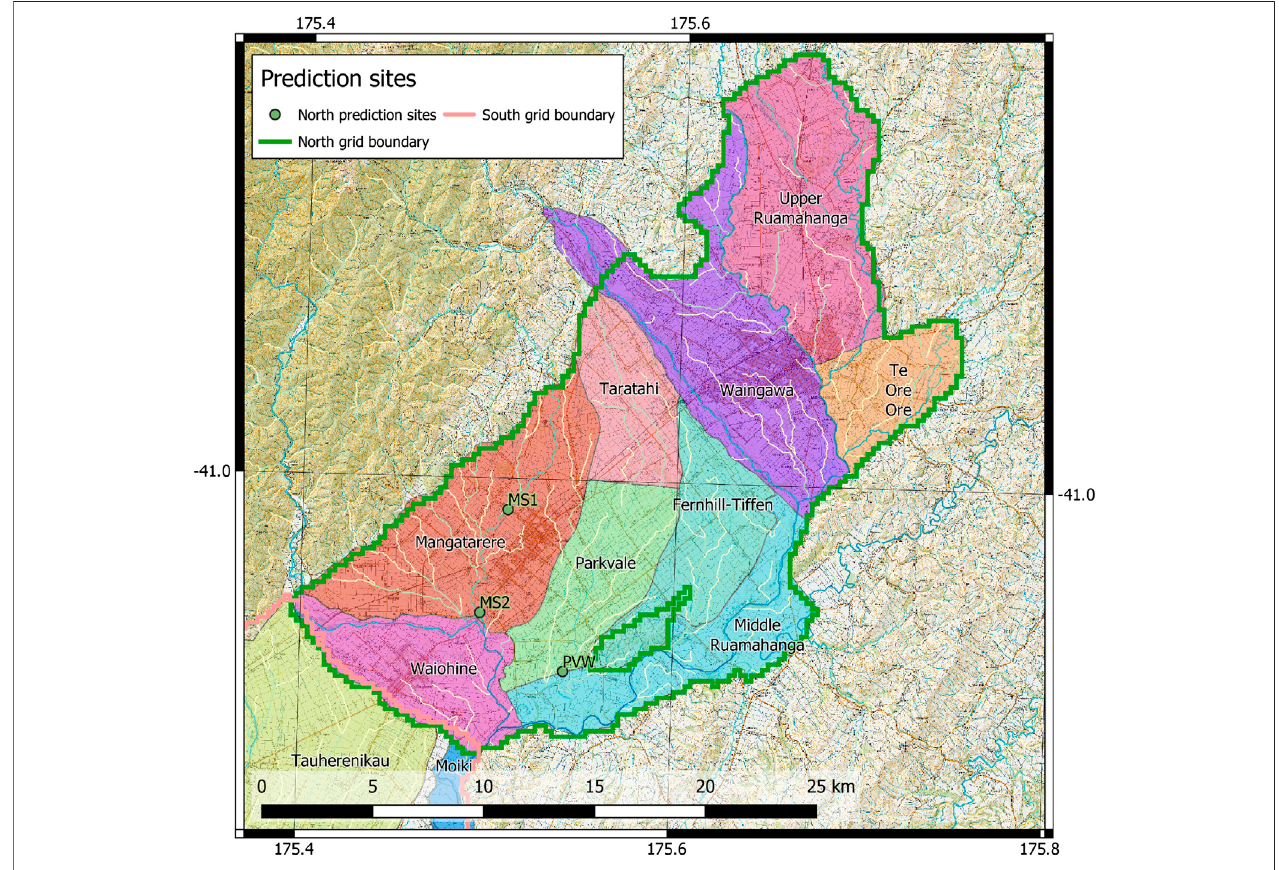
FIGURE 2 | Decision-relevant forecast locations. Stream fl ow reliability forecasts are indicated by green dots. Groundwater management zones (GMZs) for mean zonal nitrate concentration forecasts are delimited by colored polygons.